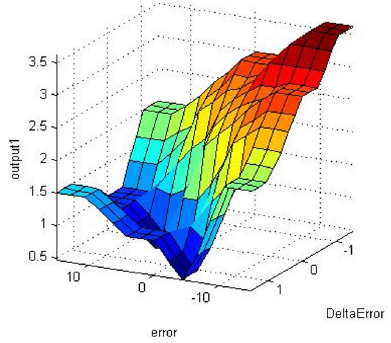
Figure 9. The surface of error, delta error and output variable.